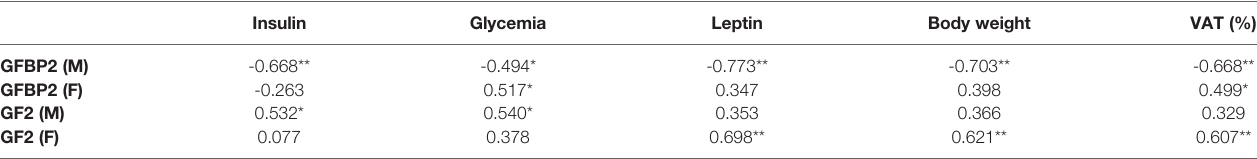
TABLE 5 | Linear correlation between circulating levels of IGF2 and IGFBP2 with peripheral insulin, glycemia, and leptin, and with body weight and visceral adipose tissue in percentage separated by sex (M, males; F, females). Insulin Glycemia Leptin Body weight